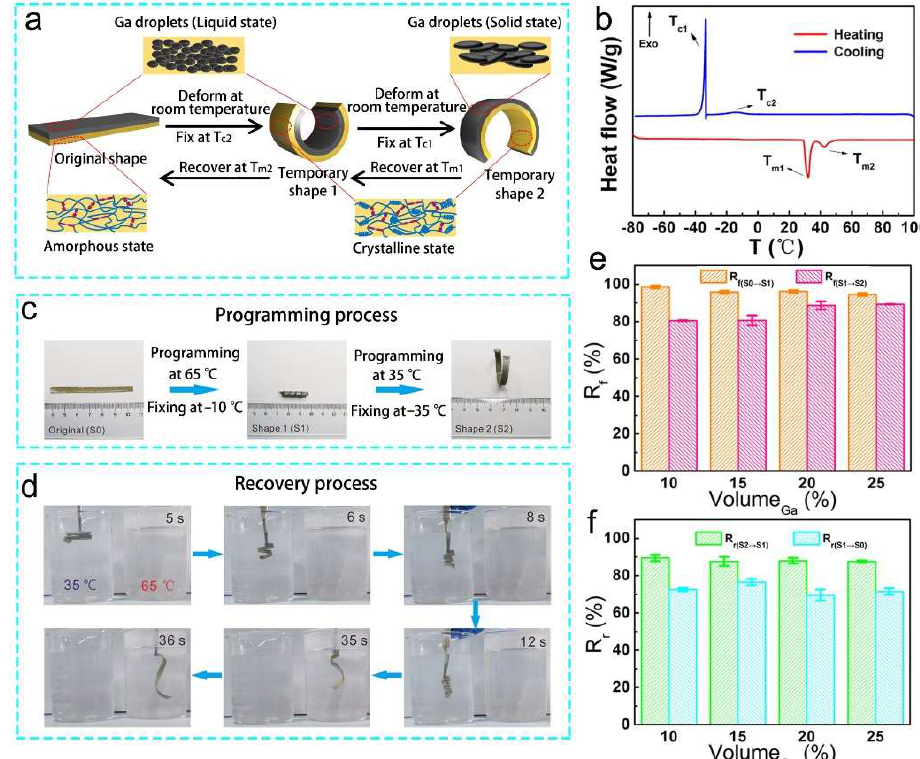
Figure 2. Shape morphing of the Ga–PU composites. ( a ) The schematic depiction of the mechanism of the dual-shape memory effect of the composite. ( b ) DSC curves of the composite (20 vol% Ga). ( c – d ) Photographs showing ( c ) the programming and ( d ) the recovery process of the dual-shape memory composite (20 vol% Ga). ( e – f ) The fixing ratio and recovery ratio for the shape change of the composites.